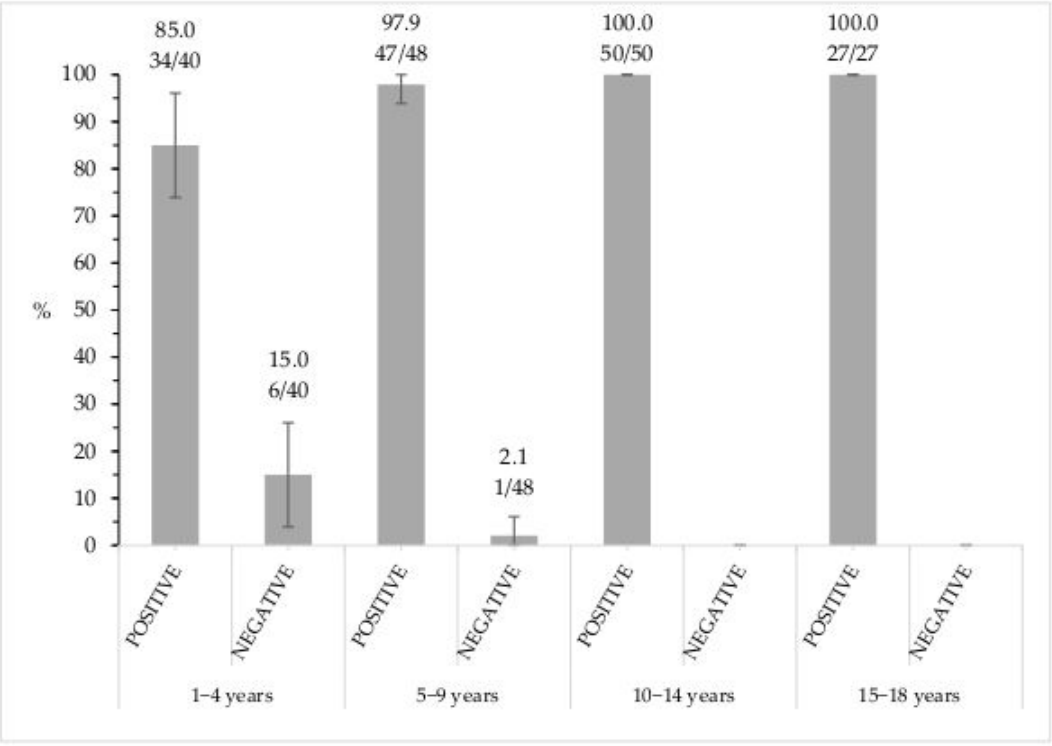
Figure 1. Percentage of rubella immunity distribution in the age